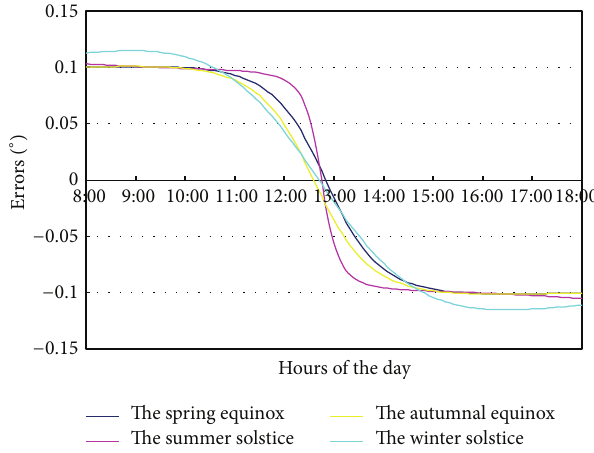
Figure 7: The tracking error of solar altitude 0.2 ∘